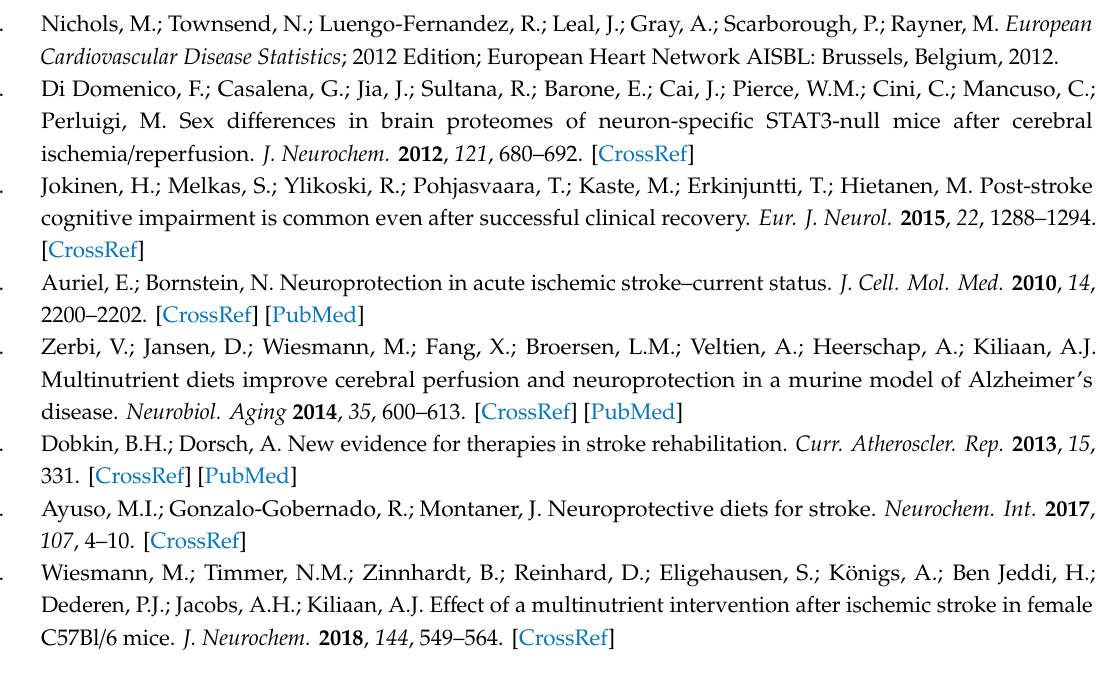
Table S1. Excluded mice per experiment. Table S2. Sequence of the PCR primers used in this study. (Used abbreviations: Bdnf, brain derived neurotrophic factor; GLUT-1, glucose transporter 1; Psd-95, postsynaptic Figure S1. A detailed explanation of the calculations on the aforementioned DVC metric measures. Figure S2. Individual locomotion via digital ventilated cage (DVC) metrics measures. (A) activity, (B) walked distance, (C,D) walked velocity, (E) total turns and (F,G) laterality index, during day- and nighttime before and after surgery. No diet e ff ects were found on DVC metrics. Notably, several stroke e ff ects were found: i.e., During nighttime, only stroke mice were less active after surgery over time ( p < 0.026) comparing presurgery with postsurgery week 1. Only during nighttime, stroke mice ( p < 0.028) showed a left turning preference (laterality) comparing presurgery with postsurgery